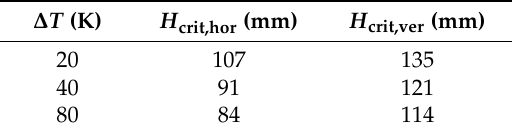
Table 2. Comparisons between horizontal and vertical critical enclosure